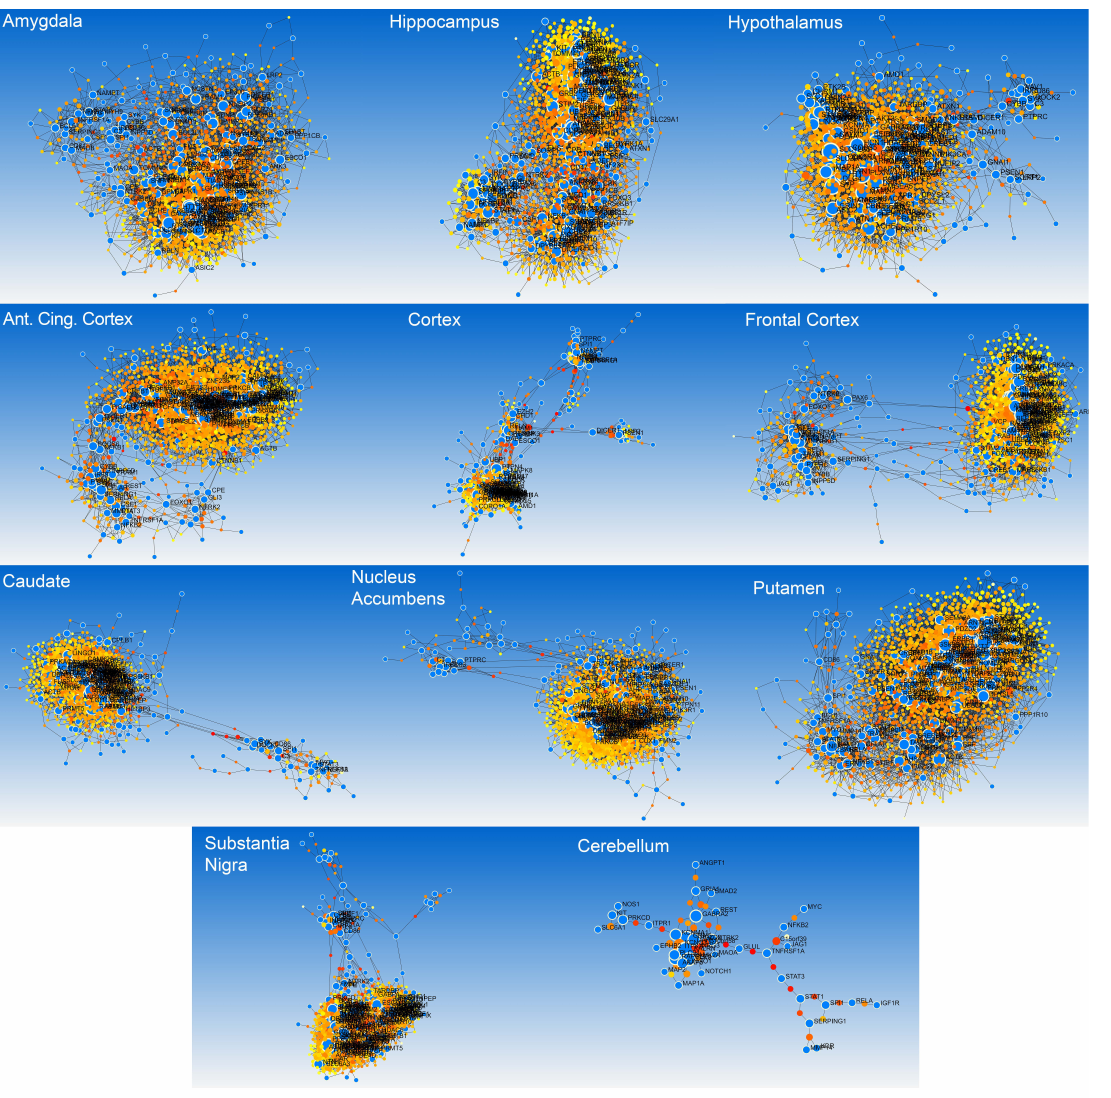
Figure 4. Co-expression networks of the MADgs genes in 11 different brain regions. Blue nodes are our input genes from MADgs